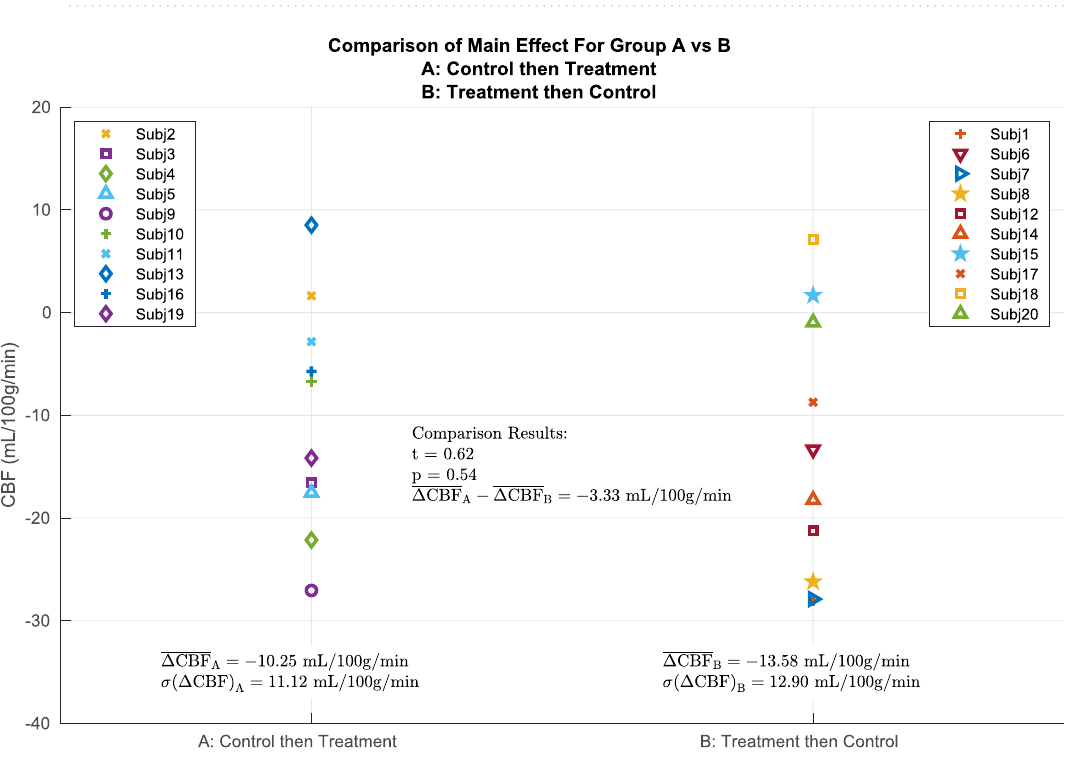
Figure 3. Post-hoc analysis with mean per-subject CBF values from the cluster shown in Fig. 2a. The Pre and Post values from the control and treatment sessions are shown in the leftmost and center pairs, respectively. The (Post–Pre) CBF differences from the control and treatments sessions are shown in the rightmost pair. There was a significant treatment-related decrease in CBF (p < 0.001, −15.90%) alongside a weak, statistically insignificant increase in the control session (p = 0.19, + 4.02%), resulting in a significant main effect (p < 0.001).